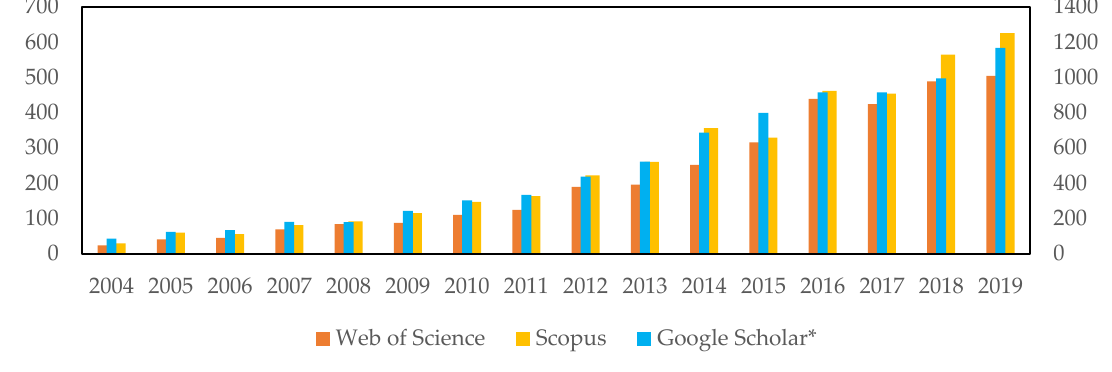
Figure 1. Search results for “ eye-tracking ” in paper titles. Note: * Uses the right axis.